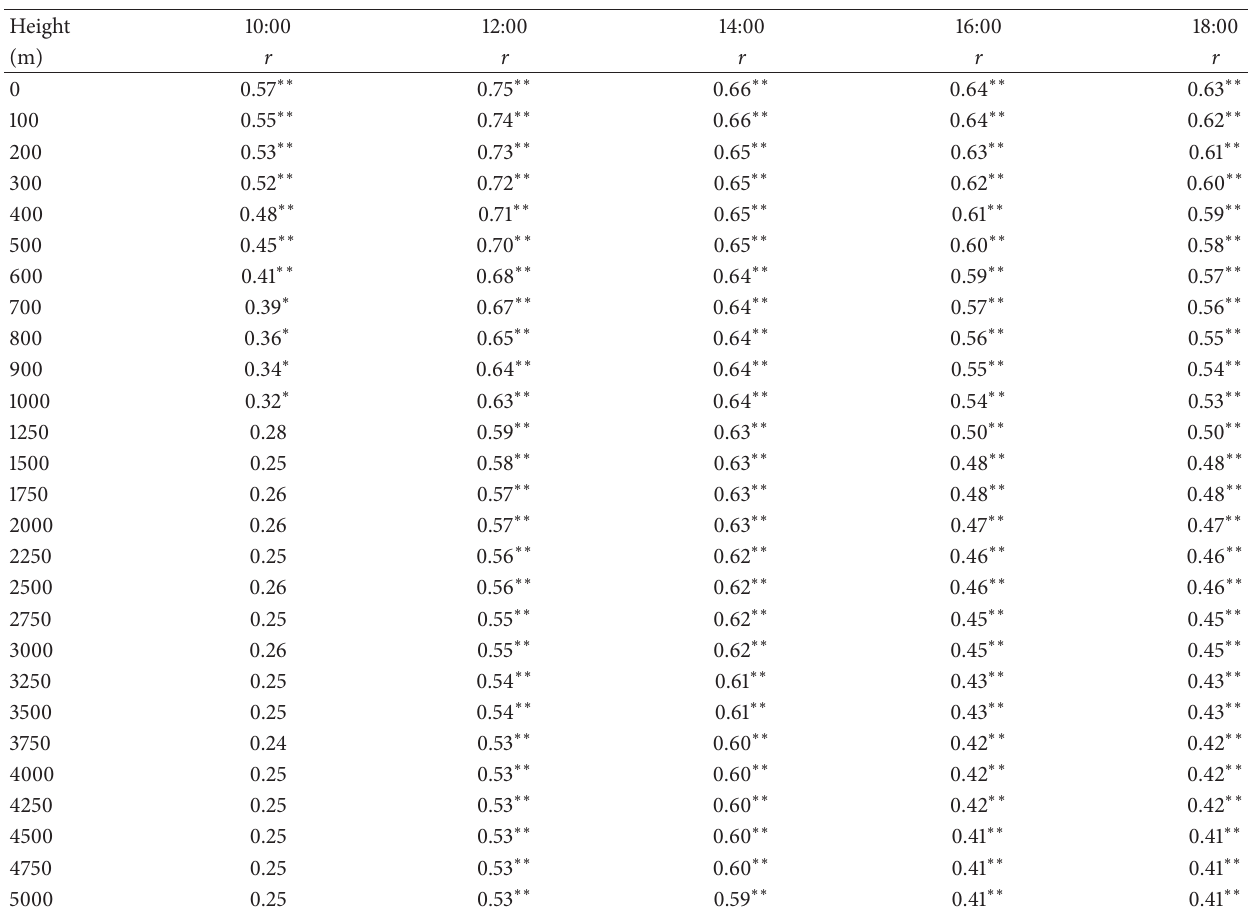
Table 4: Statistical correlations between PBLH and air temperature at different heights and at different times ( r : Pearson correlation